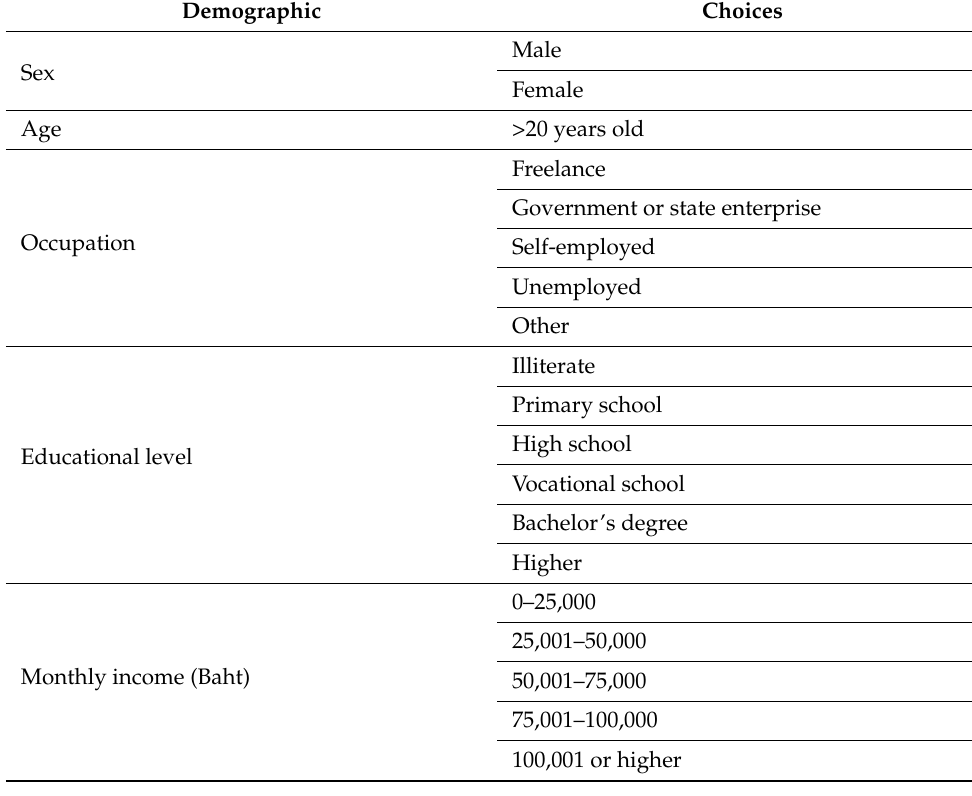
Table 1. Demographic information.